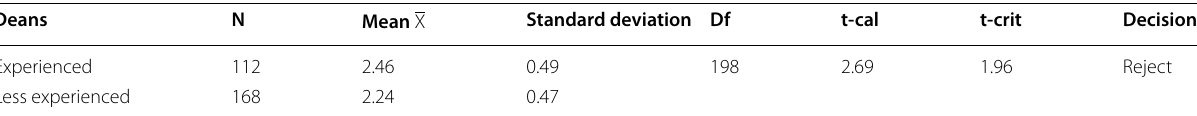
Table 5 Test for significant difference in experienced and less experienced university Deans’ cognizance of the need for quality assurance in school